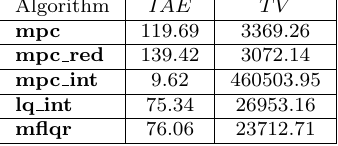
Table 2: The table shows the Integral Absolute Error indices IAE (Eq. (28)) and Total input Value (Eq. (29)) for mpc , mpc red , mpc int , lq int and mflqr algorithms corresponding to reference/setpoint response in yaw rotation/-